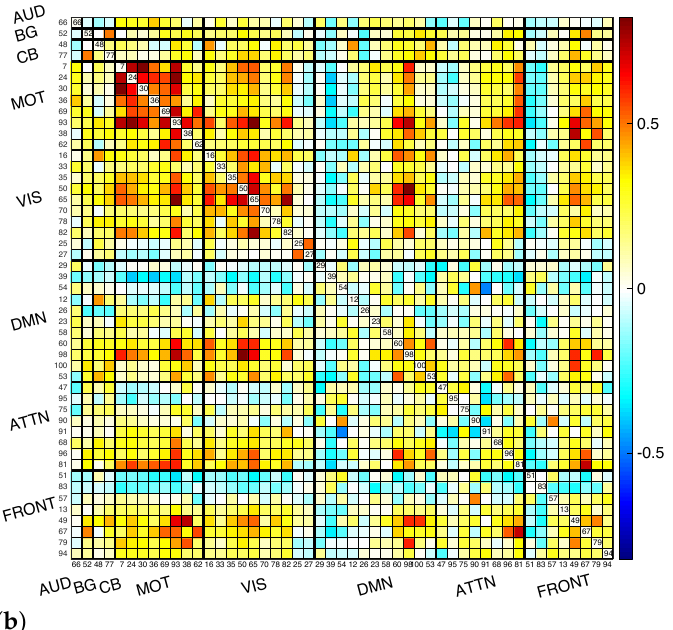
Figure 3. Selected functional network references and the corresponding aggregate functional network connectivity matrix. ( a ) Visualization of the selected functional network references, which were separated into eight functional areas based on their anatomical and functional properties. In each functional area, one color in the composite maps corresponds to one component. ( b ) Aggregated functional network connectivity matrix. Pairwise correlations between resting-state networks’ time courses are first Fisher z-transformed and averaged across all subjects, then inverse z-transformed back to